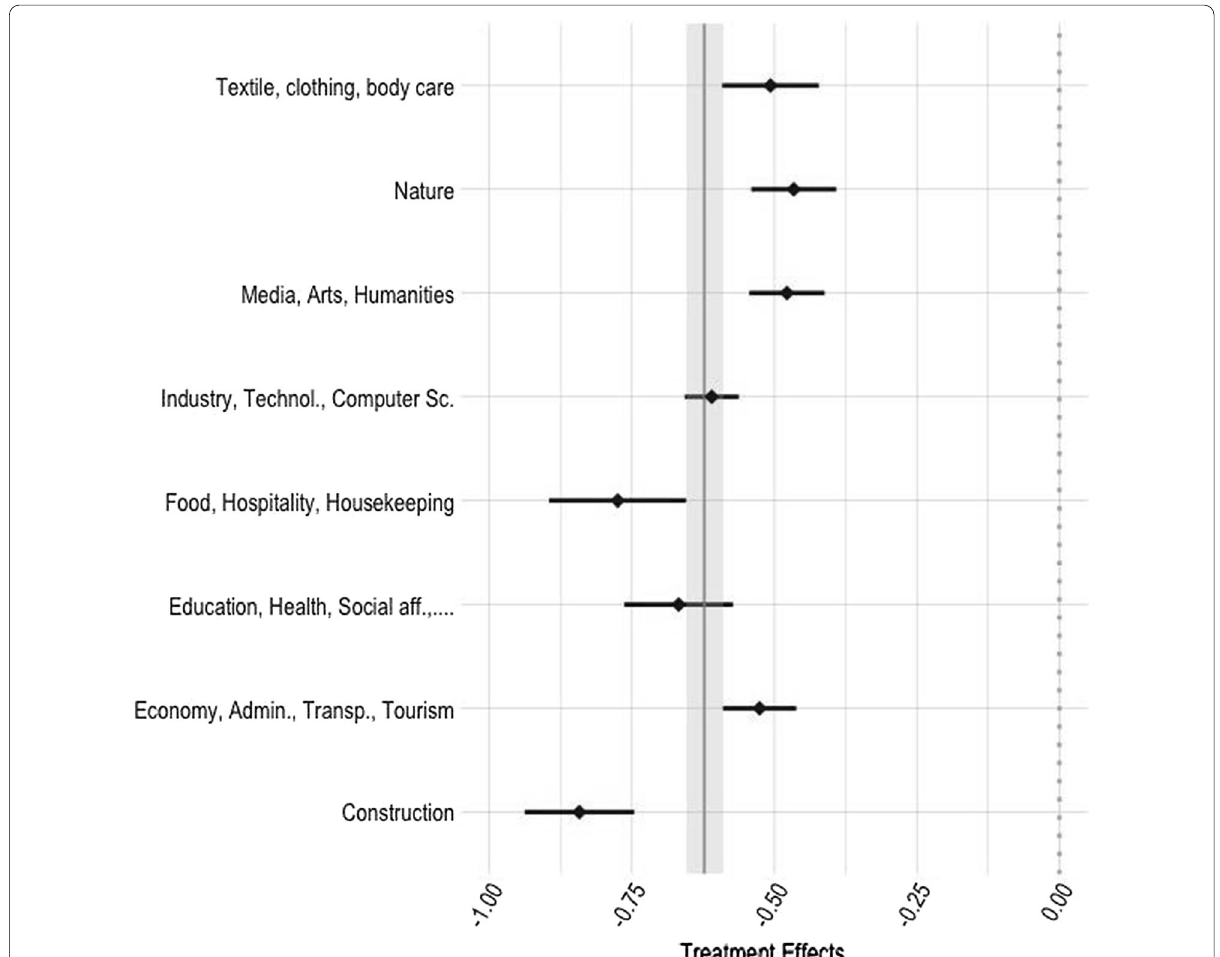
Fig. 3 Treatment effect by occupation, 8 categories. Correlation of Stringency Index and daily queries; linear model—specification as in Table 4, Panel A, column (1). Blue diamonds are the point estimates for the specific region accompanied by the 95% confidence interval. Vertical solid grey line (with grey shaded confidence interval) is the population average effect. Eight categories according to the SwissDoc